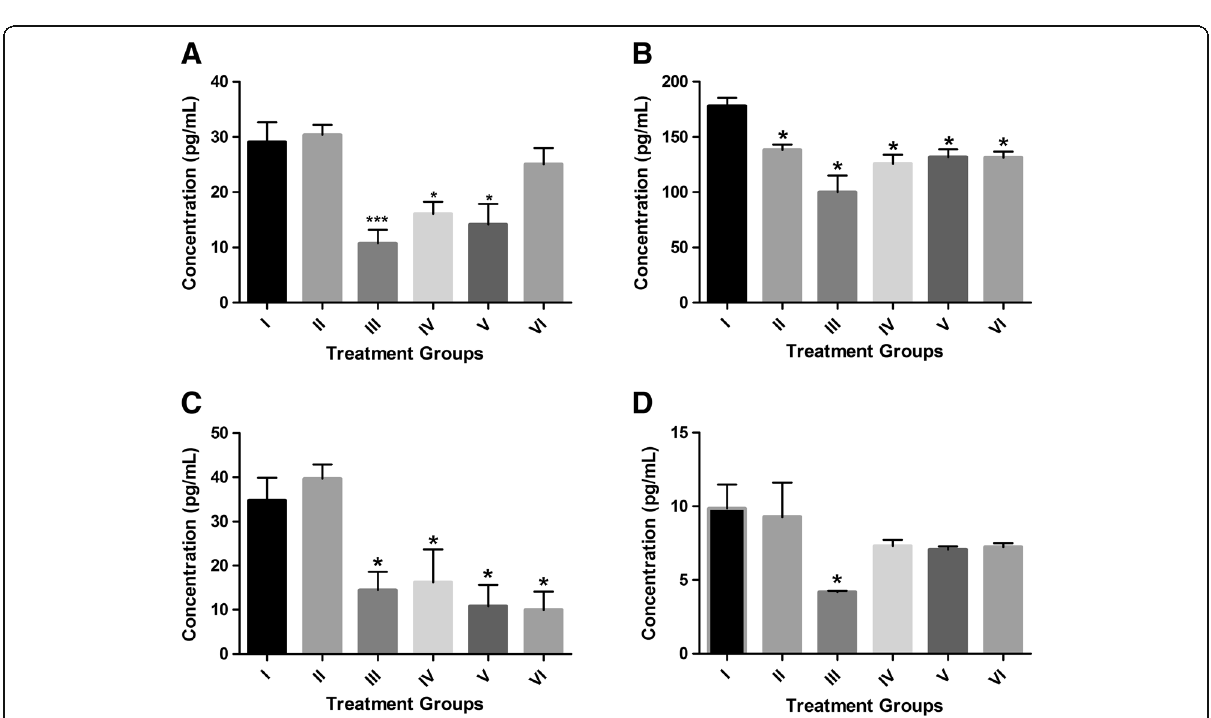
Fig. 4 Cytokine concentration in different treatment groups of mice. a IL-1 α , b IL-1 β , c IL-4 and d IL-9. In the IL-1 α test group III, IV and V, a significant reduction was observed when compared with group II mice. The IL-4 level was significantly reduced in groups III, V and VI when compared with group II mice. No significant difference was observed in IL-1 β and IL-9 levels in any treatment groups